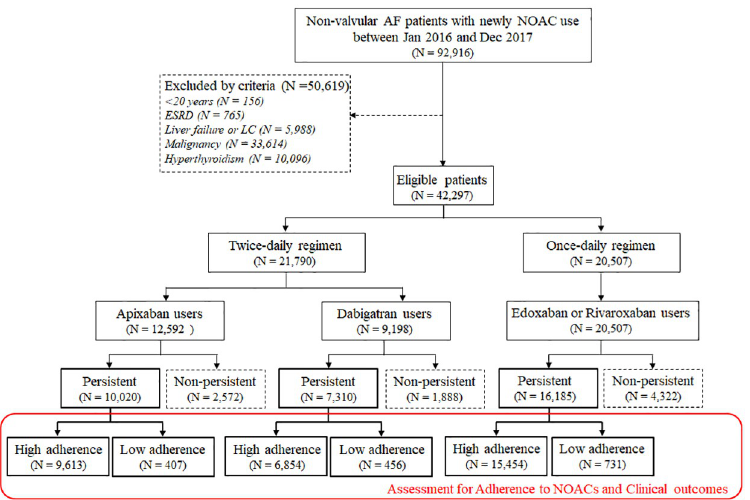
Fig 1. Study flowchart. AF, atrial fibrillation; NOAC, non-vitamin K antagonist oral anticoagulant; ESRD, end-stage renal disease; LC, liver cirrhosis.